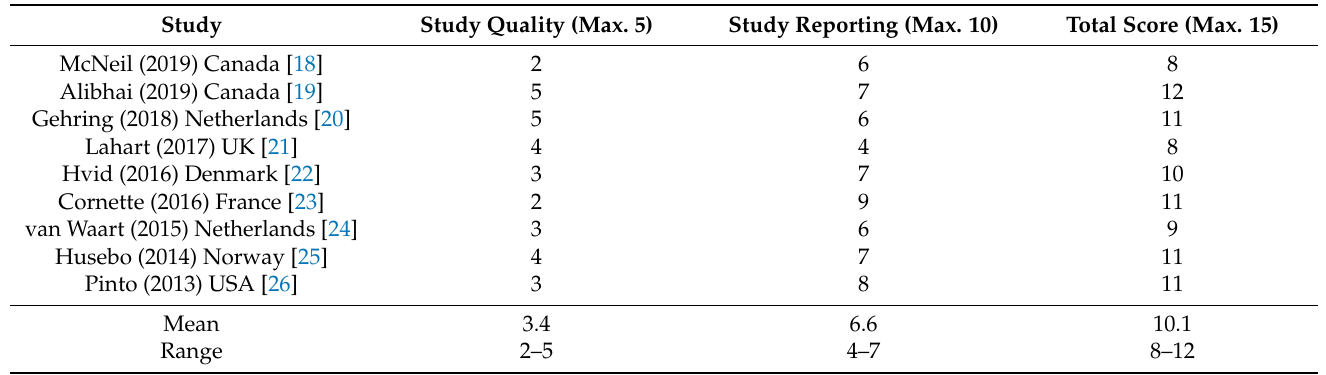
Table A1. The results of the study quality and reporting using the TESTEX scale